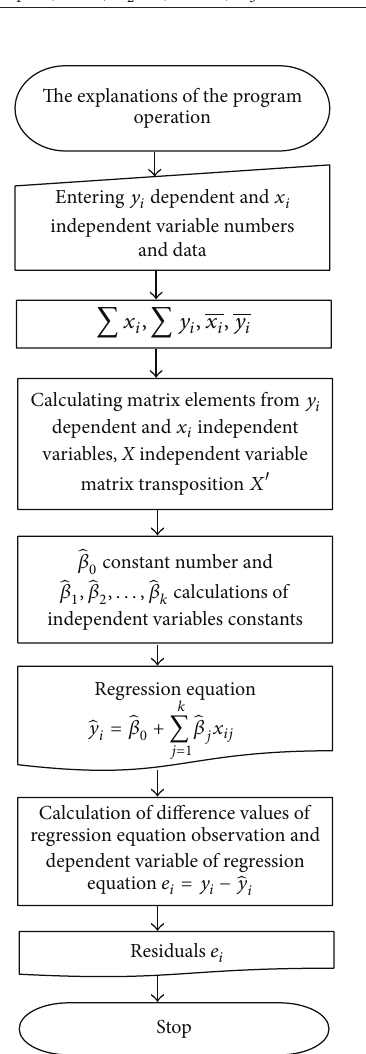
Figure 1: The designed algorithm for the regression